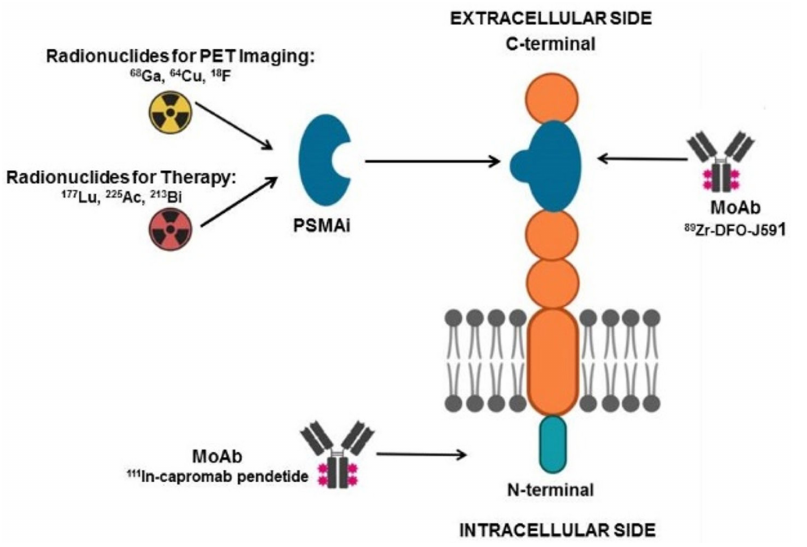
Figure 1. Schematic representation of PSMA molecular structure. PSMA inhibitors (PSMAi) expolit glutamate carboxypeptidase enzymatic activity of the extracellular domain of PSMA and can be labeled either with positron-emitting nuclides (e.g., 68 Ga, 64 Cu, 18 F) for imaging or with beta/alpha emitting radioisotopes (e.g., 177 Lu, 213 Bi, 225 Ac) for radionuclide therapy. Monoclonal antibodies (MoAbs) have also been developed: 111 In-capromab is directed towards the intracellular PSMA domain and is utilized for scintigraphic imaging, 89 Zr-DFO-J591 targets the extracellular portion of PSMA and is suitable for PET imaging (figure created with Biorender.com (accessed on 8 March